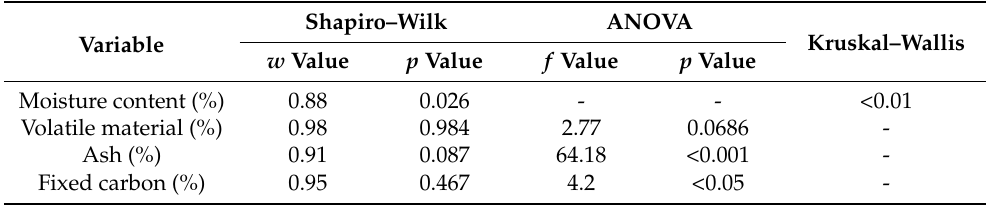
Table 3. Normality tests and analysis of variance of proximal analysis of pellets made with Agave durangensis fibers and Pinus spp. sawdust